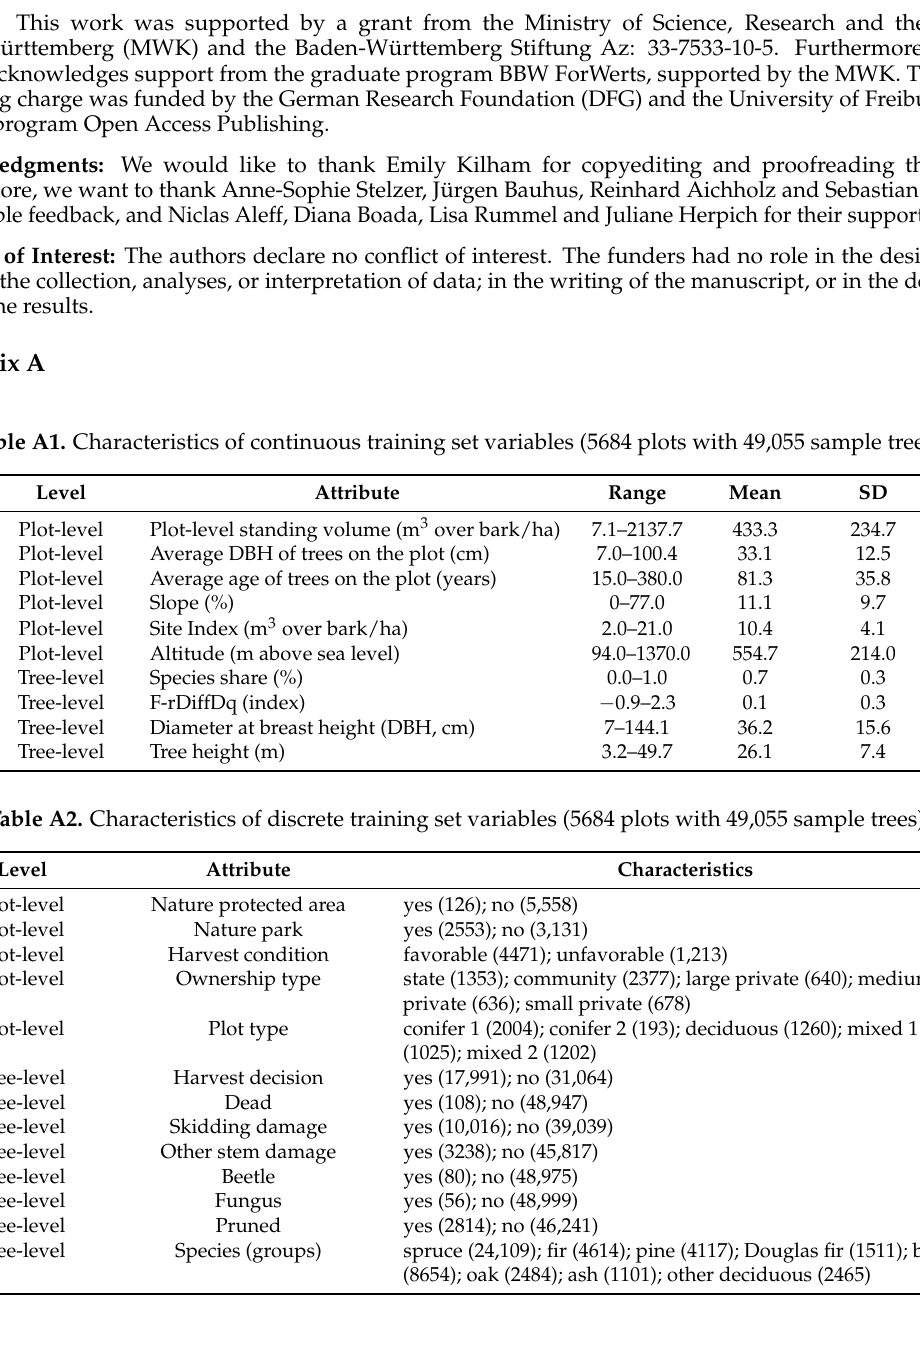
Table S1: Training and prediction process for a combination of plot-level and tree-level harvest predictions based on a randomized approach. Table S2: Test set results for the randomized plot-level prediction based on probabilities derived with conditional inference trees random forest (CTree-RF). Figure S1. Standardized variable importance (VI) as permutation importance for the plot-level random forest (RF) based on conditional inference trees (CTree). Figure S2. Comparing predicted average harvested volumes (combined randomized plot- and tree-level models) to national forest inventory (NFI) measurements on species level for the period 2002–2012. ( a ) conifer species. ( b ) deciduous species. Figure S3. Comparing 2002–2012 predicted average harvested volumes (combined randomized plot- and tree-level models) to the national forest inventory (NFI) for species (groups) and selected data subsets.